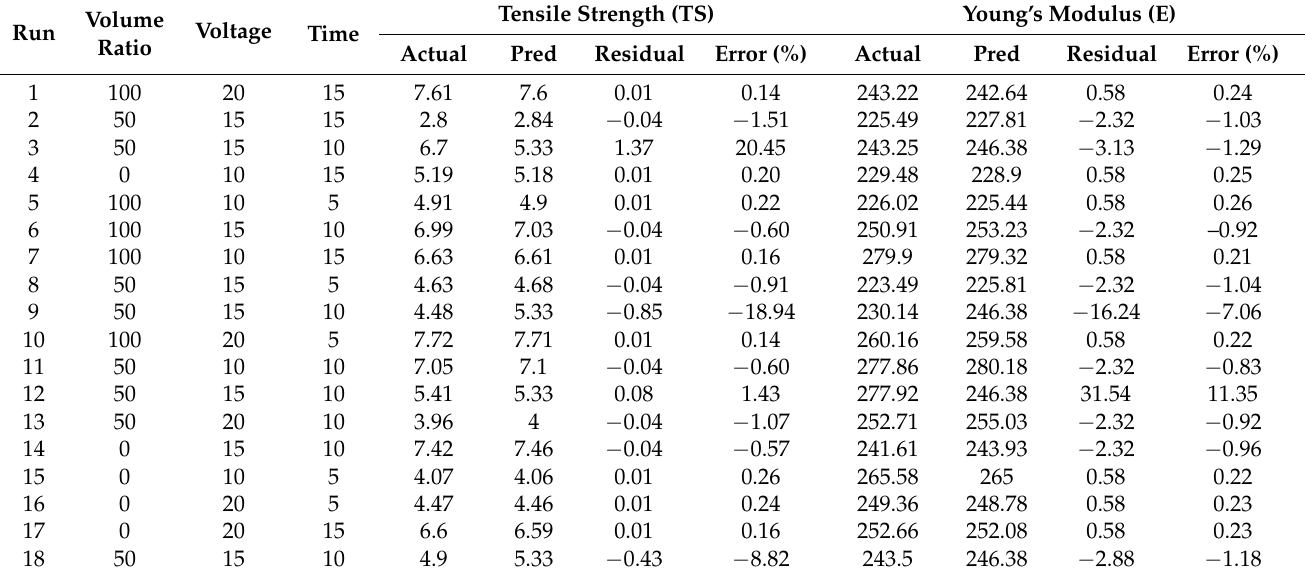
Table 11. Experimental and predicted results of the output response for experimental design of 0% and 100% water.